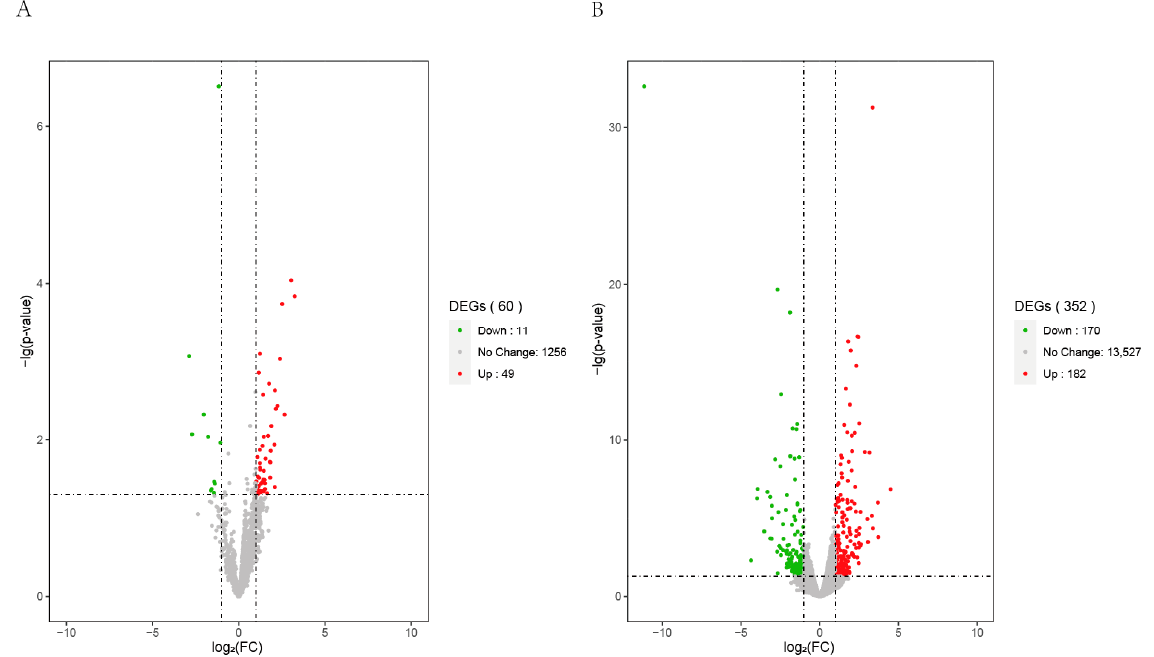
Figure 4. Volcanic map of differentially expressed lncRNAs and mRNAs in goat skin in different periods (Day 45 and Day 108): ( A ) Among the differentially expressed lncRNAs, 49 were up-regulated and 11 were down-regulated; ( B ) Among the differentially expressed mRNAs, 182 were up-regulated and 170 were down-regulated.